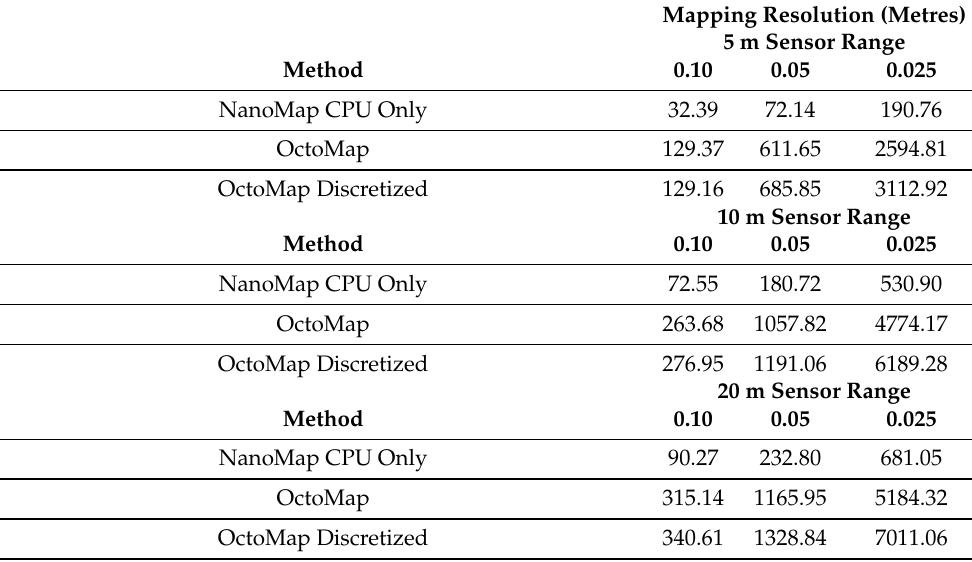
Table 7. Laser dataset average frame time for Asus G14 (ms, lower is